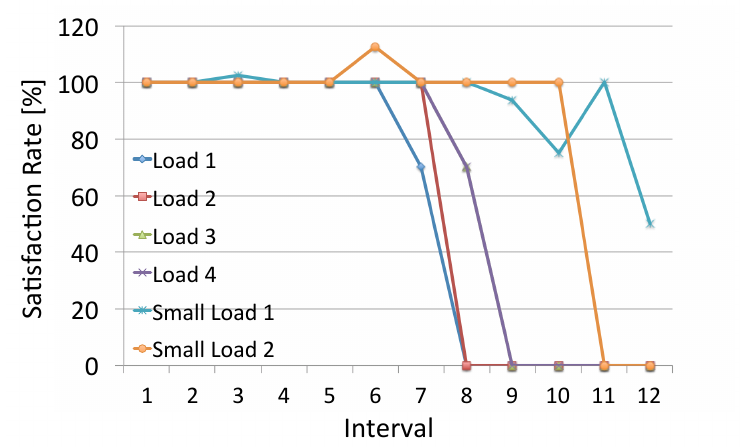
Figure 22. The transition of the demand satisfaction